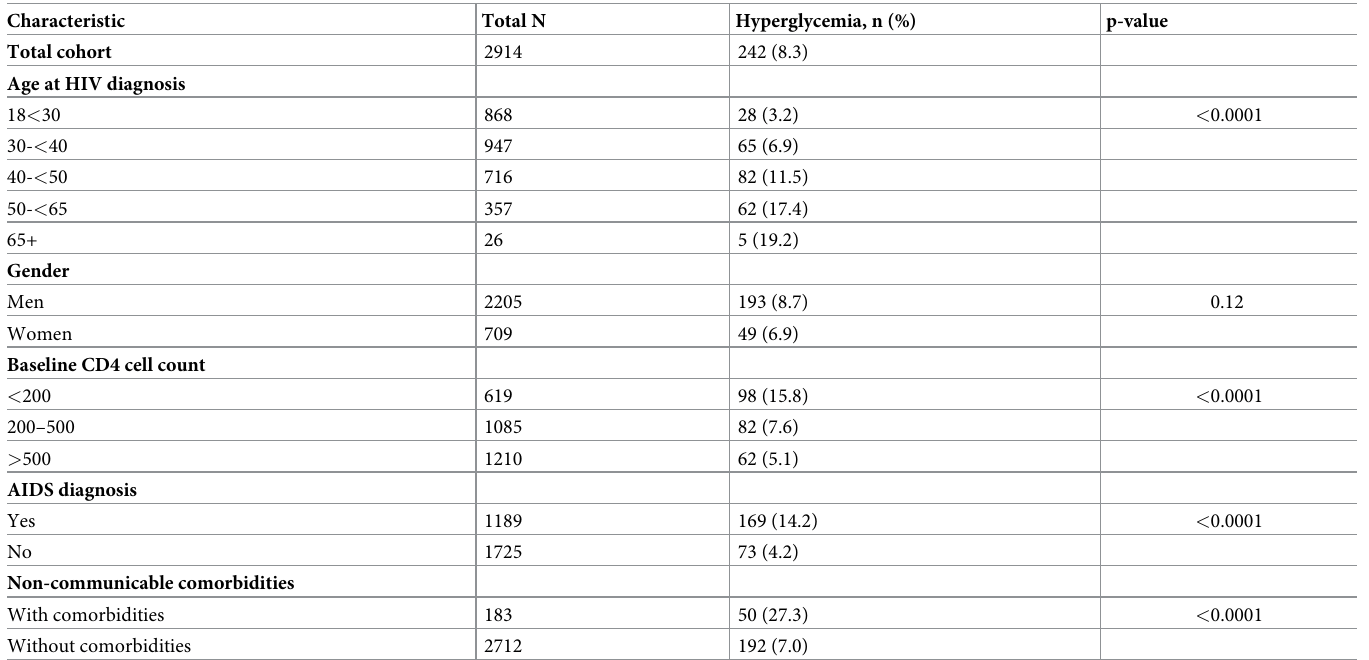
Table 1. Study population characteristics and prevalence of hyperglycemia by baseline characteristics (n = 2914).